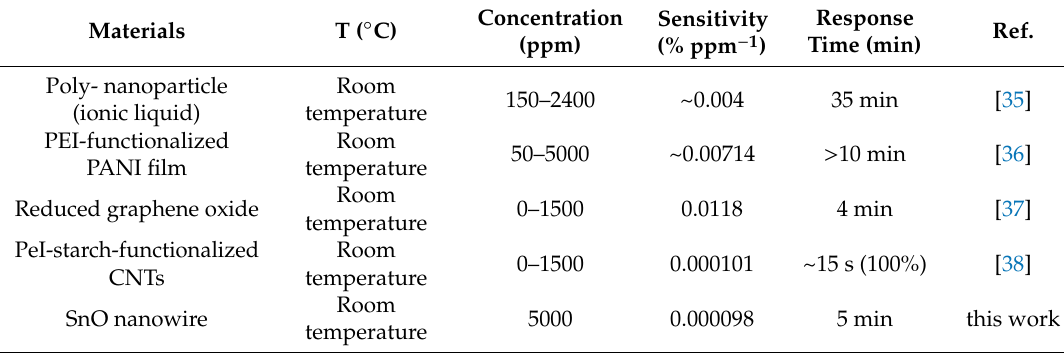
Table 1. Comparison of CO 2 sensing properties with reported